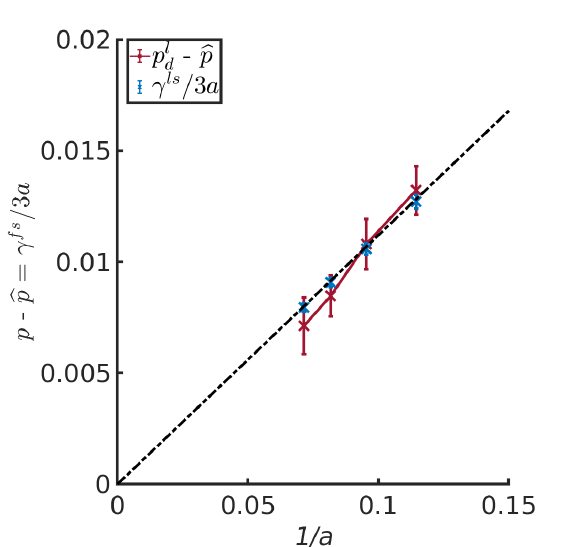
Figure 7. Difference between p and (cid:98) p for the liquid REV 2 as a function of the inverse half channel width for α =